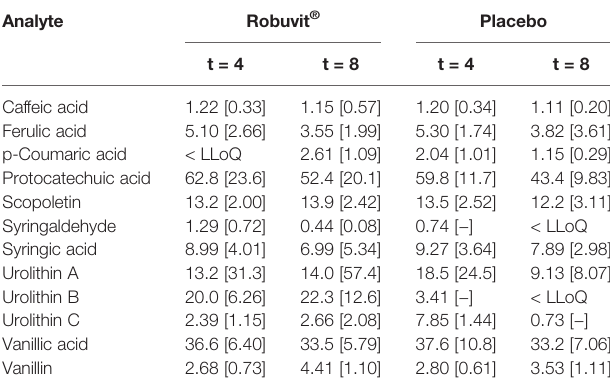
TABLE 1 | Serum concentrations in the Robuvit ® and placebo group after 4 and 8 weeks. All other analytes revealed concentrations below the lower limit of quanti fi